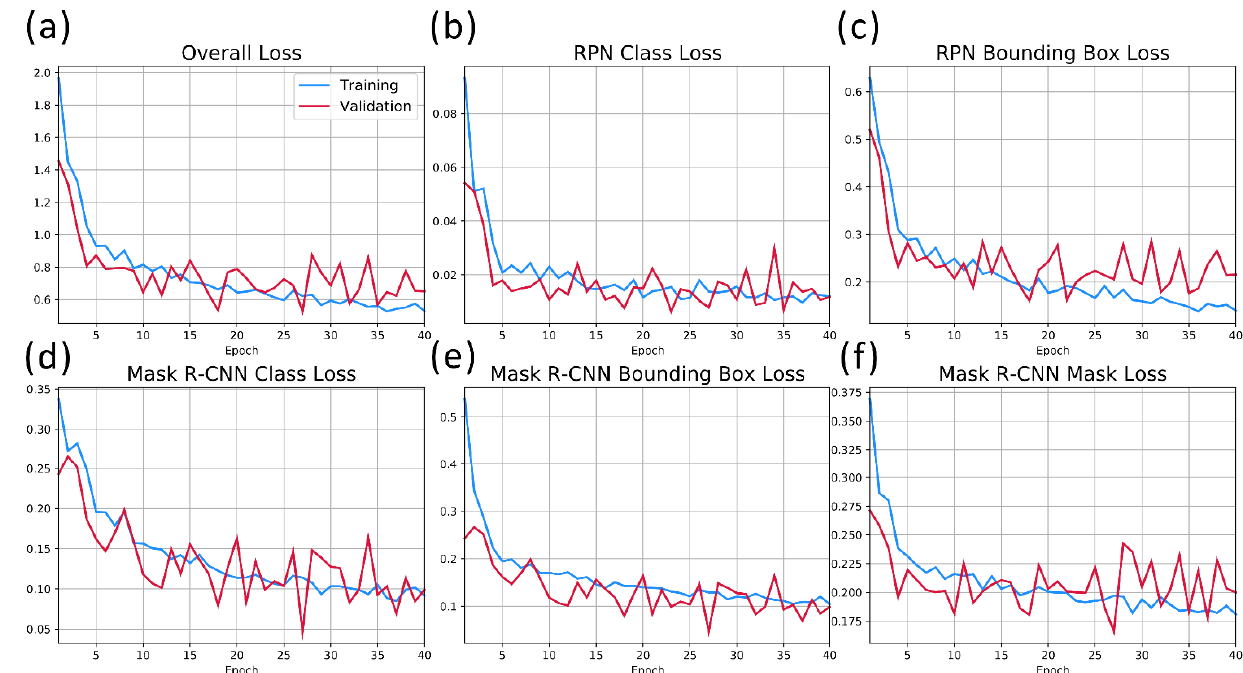
Figure 3. Loss curves of Mask region-based convolutional neural networks (Mask R-CNN) on training and validation datasets. ( a ) Overall loss is the sum of losses in ( b–f ). ( b ) Region Proposal Network (RPN) class loss measures how well the RPN anchor classifier separates the objects with background. ( c ) RPN bounding box loss represents how well the RPN localizes objects. ( d ) Mask R-CNN class loss is used to measure how well the Mask R-CNN recognizes the category of object. ( e ) Mask R-CNN bounding box loss measures how well the Mask R-CNN localizes objects. ( f ) Mask R-CNN mask loss evaluates how well the Mask R-CNN segments each object instance.